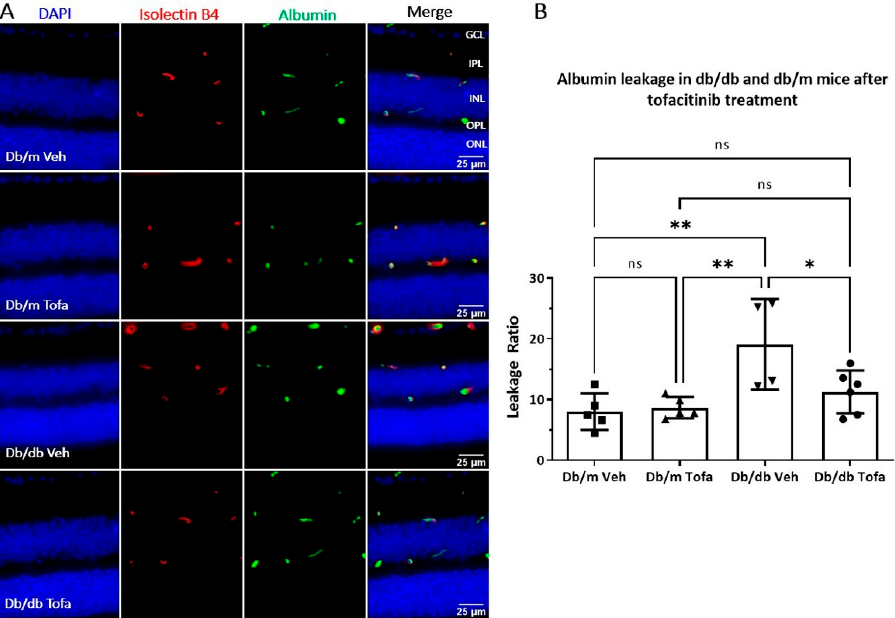
Figure 6. The effect of tofacitinib citrate on albumin leakage in db/db mice. Two and a half months old db/db and db/m mice were treated with tofacitinib citrate or vehicle for 2 weeks. Eyes were then collected and stained for isolectin B4 (red) and albumin (green). ( A ) Representative images showing isolectin B4 and albumin in db/m and db/db mice treated with either tofacitinib citrate or vehicle control. GCL—ganglion cell layer; IPL—inner plexiform layer; INL—inner nuclear layer; OPL— outer plexiform layer; ONL—outer nuclear layer. ( B ) Quantification of albumin extravasation. Mean ± SD, * p < 0.05, ** p < 0.01 by One Way ANOVA followed by Tukey ′ s multiple comparisons.